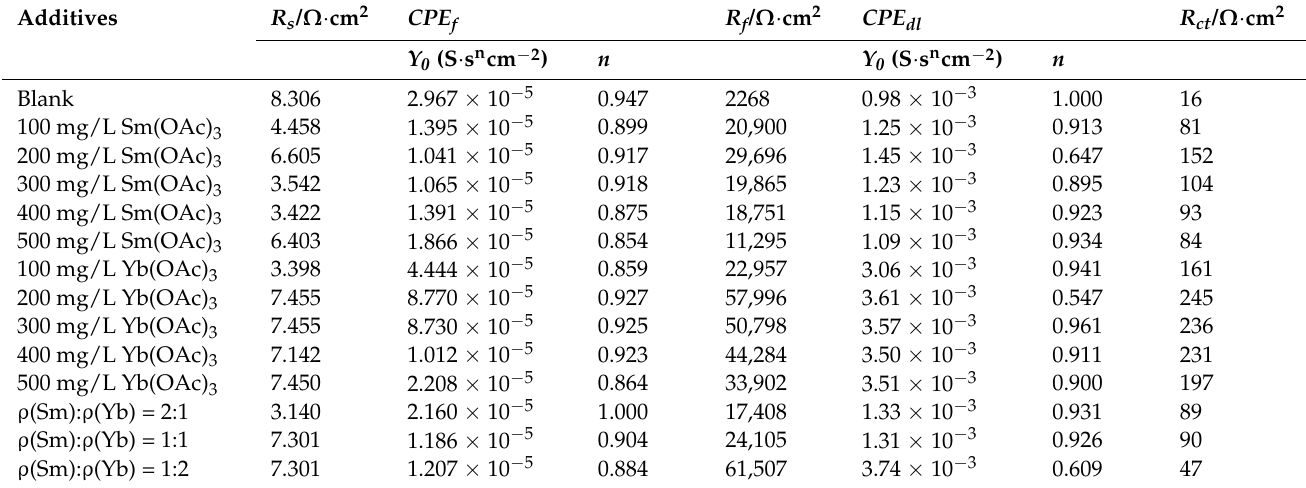
Table 2. Electrochemical parameters extracted from modeling the Nyquist and Bode diagrams for aluminum anode in 3.5 wt.% NaCl solution with different